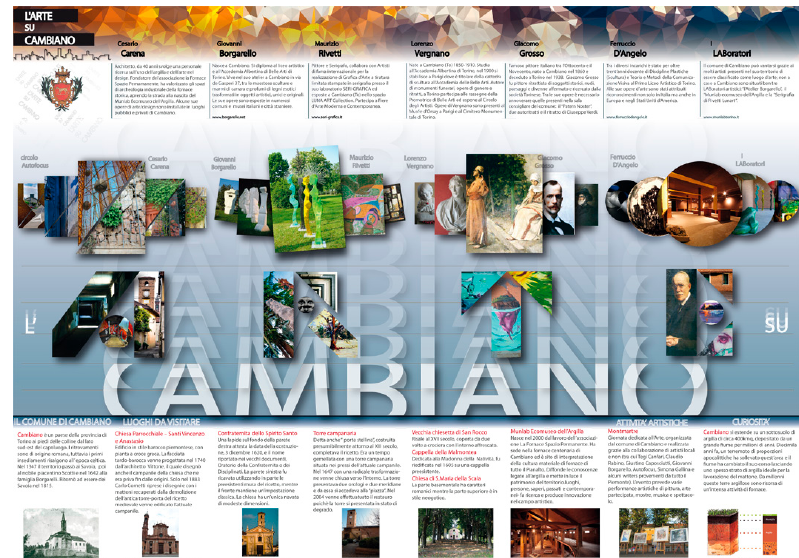
Figure 2. The inside face of one of Cambiano’s artistic promotion brochures. In this page, in addition to the artists’ biography and monuments’ historical information, there are selected images referring to the artistic